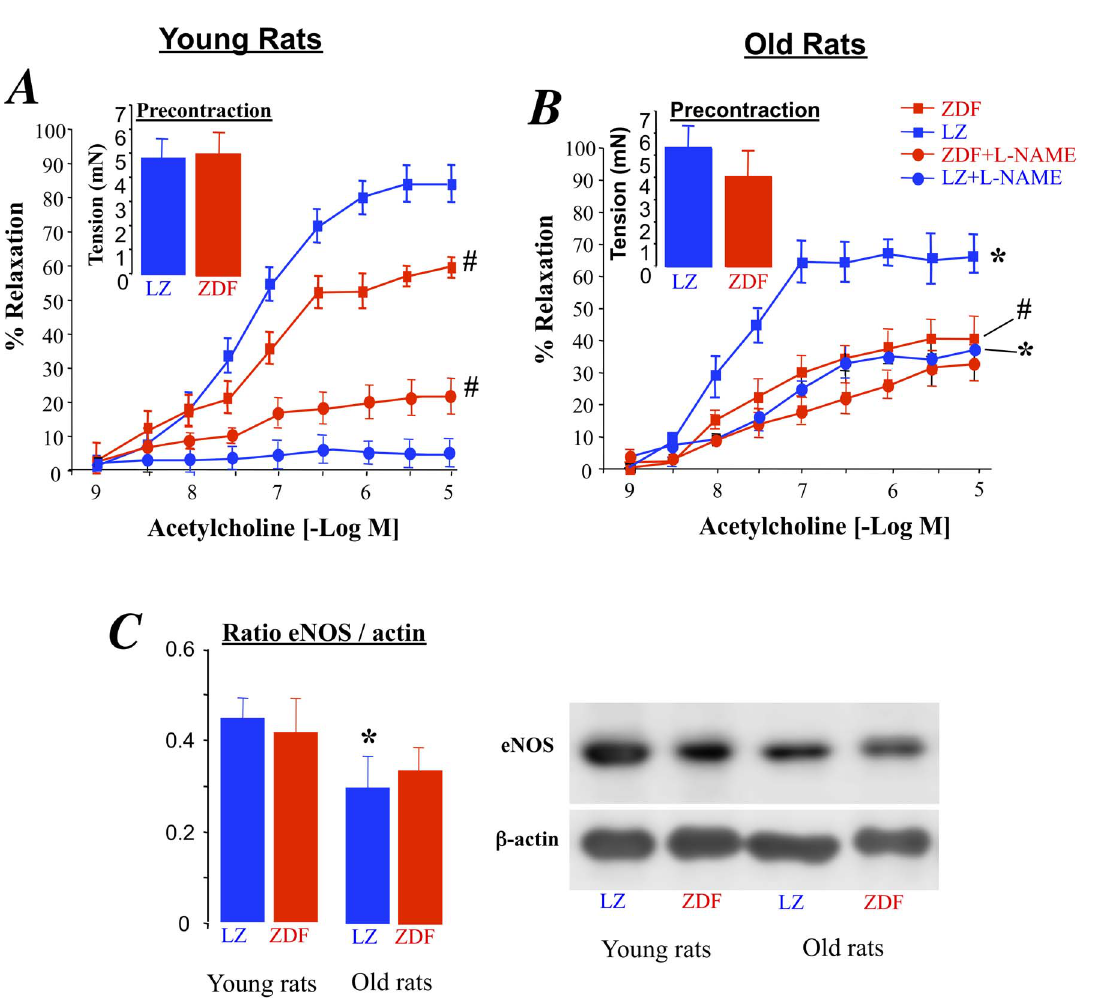
Figure 1. Acetylcholine-induced relaxation in young (A) and old (B) LZ and ZDF rats. Relaxation was obtained before and after NO synthesis inhibition with the NO synthesis blocker L-NAME. The inserts show the precontraction applied before adding acetylcholine. Beta-actin and eNOS expression levels were measured using Western-Blot analysis (typical blots on the right side). Data is given as a ratio eNOS/beta-actin ( C ). Mean 6 SEM is presented (n=10 per group). # P , 0.01, ZDF versus LZ. *P , 0.01, old versus young